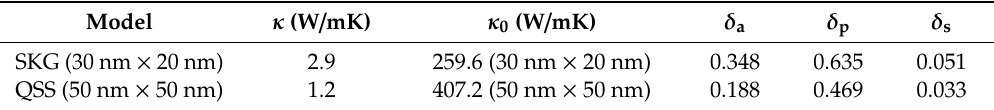
Table 1. The values of δ a , δ p , and δ s of the SKG and QSS. κ and κ 0 represents the thermal conductivity of KGS and pristine graphene.